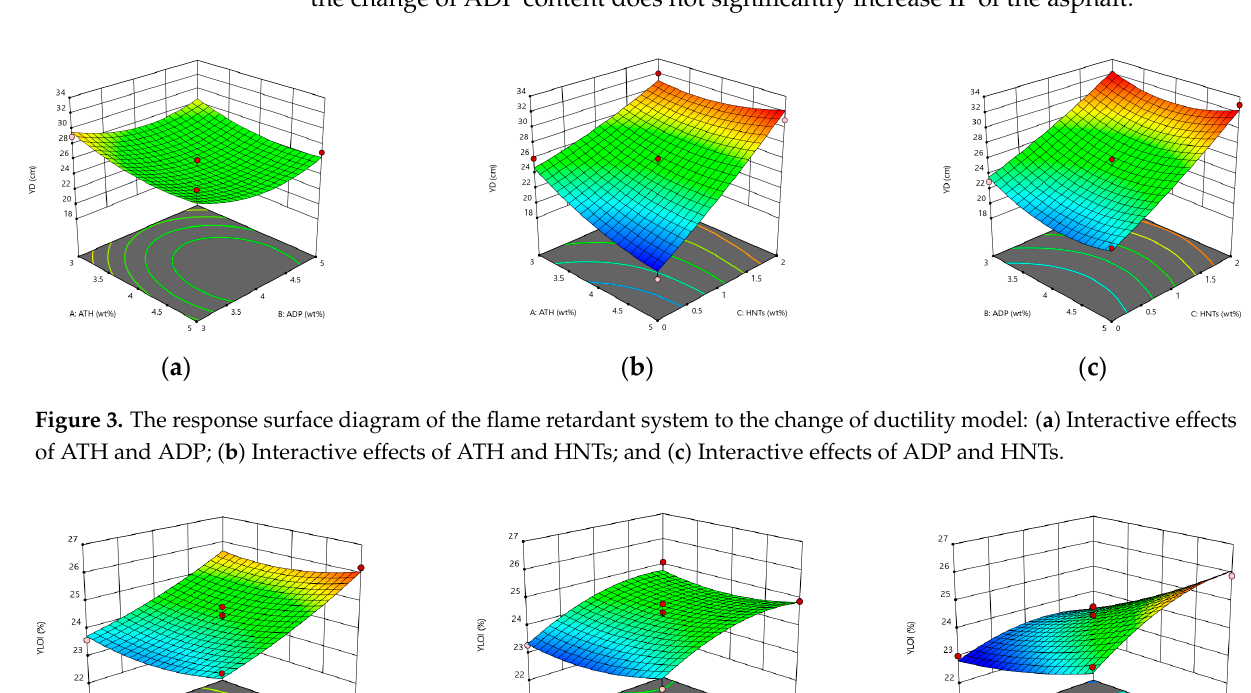
Figure 3. The response surface diagram of the flame retardant system to the change of ductility model: ( a ) Interactive effects of ATH and ADP; ( b ) Interactive effects of ATH and HNTs; and ( c ) Interactive effects of ADP and HNTs.